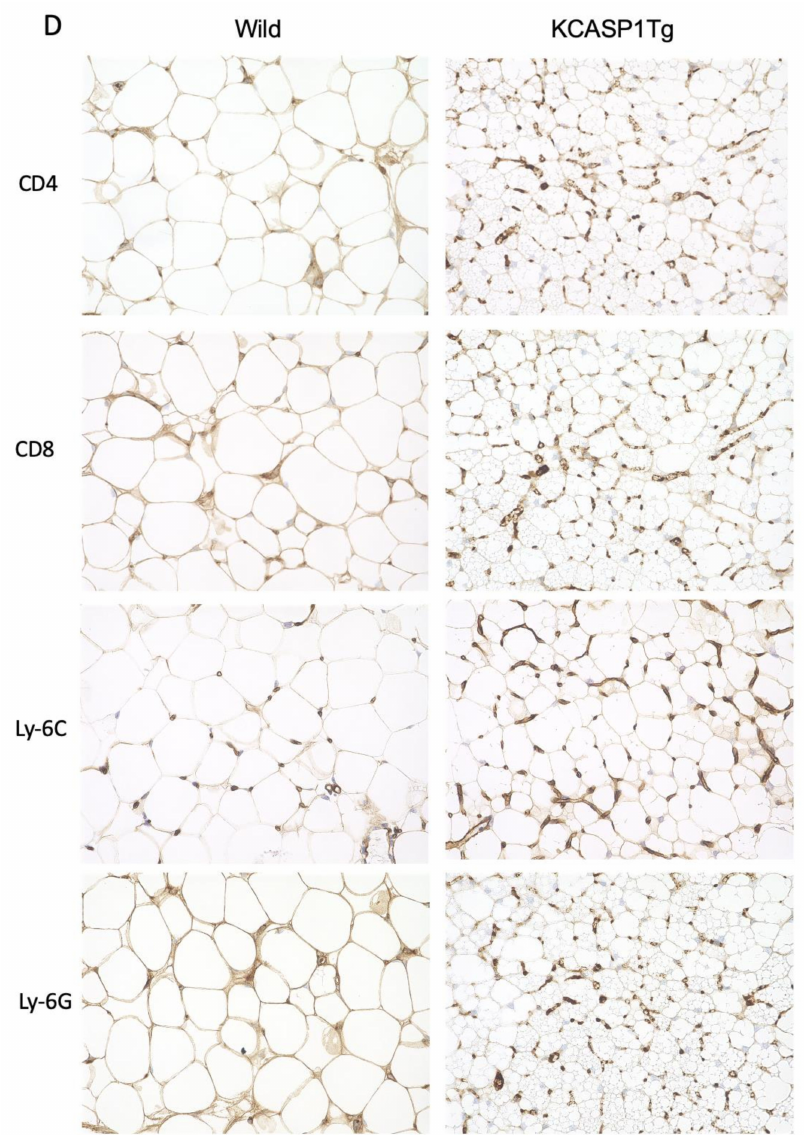
Figure 1. KCASP1Tg mice showed low gonadal white adipose tissue (GWAT) weights and degenerated adipose tissue (AT). ( A ) The whole body and ( B ) GWAT weights were decreased in KCASP1Tg compared to wild littermate mice at 10 weeks of age. ( C ) Representative photomicrographs of the hematoxylin and eosin (HE) ( × 400) staining of the GWAT of wild littermate and KCASP1Tg mice at 10 weeks of age. Histological sections were 3.5 µ m thick. Adipocyte number and adipocyte area were measured by using ImageJ and Adiposoft (three parts of each slide, n = 3 in each group). Adipocytes were significantly smaller and larger in number in KCASP1Tg. ( D ) Immunohistochemical staining ( × 400) was performed to characterize stromal cells. Lymphocytes, monocytes and neutrophils were slightly higher in KCASP1Tg but not significantly so. ** p < 0.01, **** p < 0.0001 versus